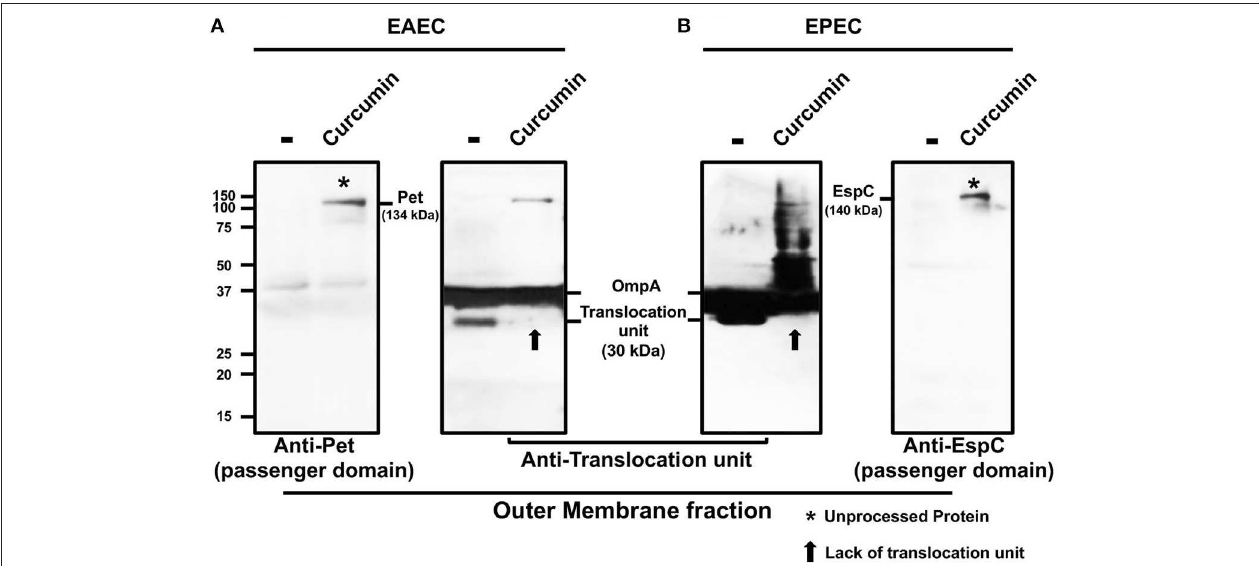
FIGURE 4 | Pet and EspC toxins remained anchored in the outer membrane in the presence of curcumin. Bacterial strains EAEC 042 and EPEC E2348/69 were incubated with or without curcumin (16 µ g/mL) for 2h at 37 ◦ C at 150 rpm. Bacterial strains were fractionated into periplasmic and OM as described in section Materials and Methods. The proteins were analyzed by Western-blot using specific primary antibodies against Pet, EspC, translocation unit ( β -domain), followed by an HRP-conjugated rabbit anti-mouse IgG2a secondary antibody. Outer membranes from treated and untreated EAEC (A) and EPEC (B) show processed and unprocessed Pet and EspC, respectively. Unprocessed protein (134 kDa for Pet and 140 kDa for EspC) consists of the passenger domain together with the translocation unit treated with curcumin (*). Arrows indicate the absence of the translocation unit ( β -domain) in presence of curcumin ( ↑